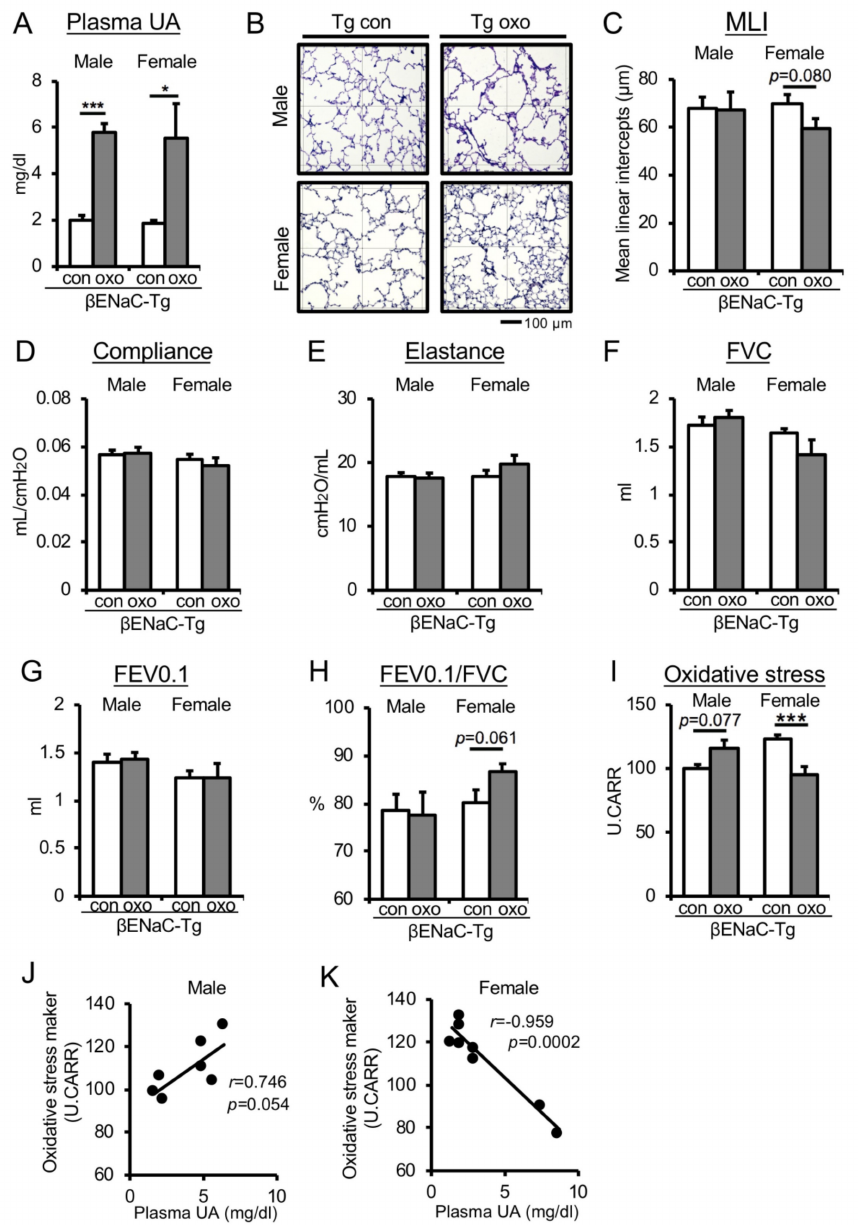
Figure 3. Treatment with oxonate decreases oxidative stress and improves pathophysiological lung phenotypes of COPD mice in a female-specific manner. ( A ) Plasma UA level (mg / dL) in vehicle-treated (con) or potassium oxonate (oxo)-treated male and female C57BL / 6J- β ENaC-Tg mice. n = 3–5 mice / group. * p < 0.05, *** p < 0.005, versus control C57BL / 6J- β ENaC-Tg; Student’s t -test. ( B,C ) Emphysematous phenotypes in con or oxo-treated male and female C57BL / 6J- β ENaC-Tg mice. ( B ) PAS and alcian blue-stained lung section. Square diameter = 300 µ m. Scale bar = 100 µ m. ( C ) Quantitative morphometric analysis of alveolar septa. n = 6–10 mice / group. Compared with control C57BL / 6J- β ENaC-Tg; Student’s t -test. ( D – H ) Parameters of pulmonary functions are indicated (compliance, elastance, FVC, FEV0.1, FEV0.1 / FVC) in con or oxo-treated male and female C57BL / 6J- β ENaC-Tg mice. n = 5–8 mice / group. * p < 0.05, versus control C57BL / 6J- β ENaC-Tg; Student’s t -test. ( I ) Plasma oxidative stress levels in con or oxo-treated male and female C57BL / 6J- β ENaC-Tg mice. n = 3–6 mice / group. *** p < 0.005 versus control C57BL / 6J- β ENaC-Tg; Student’s t -test. ( J – K ) Correlation scatter plots of plasma UA and oxidative stress levels in con or oxo-treated male ( J ) and female ( K ) C57BL / 6J- β ENaC-Tg mice. Pearson’s correlation coefficient test. Data expressed as mean ±